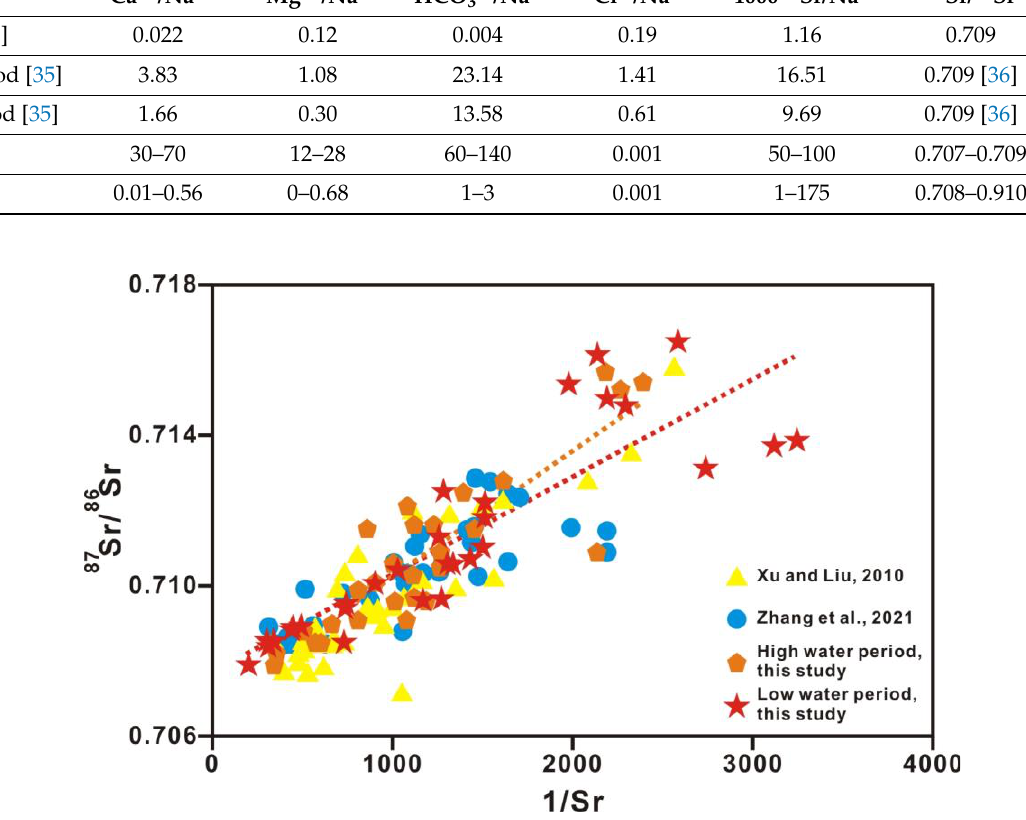
Table 2. Parameters of each model end-member.